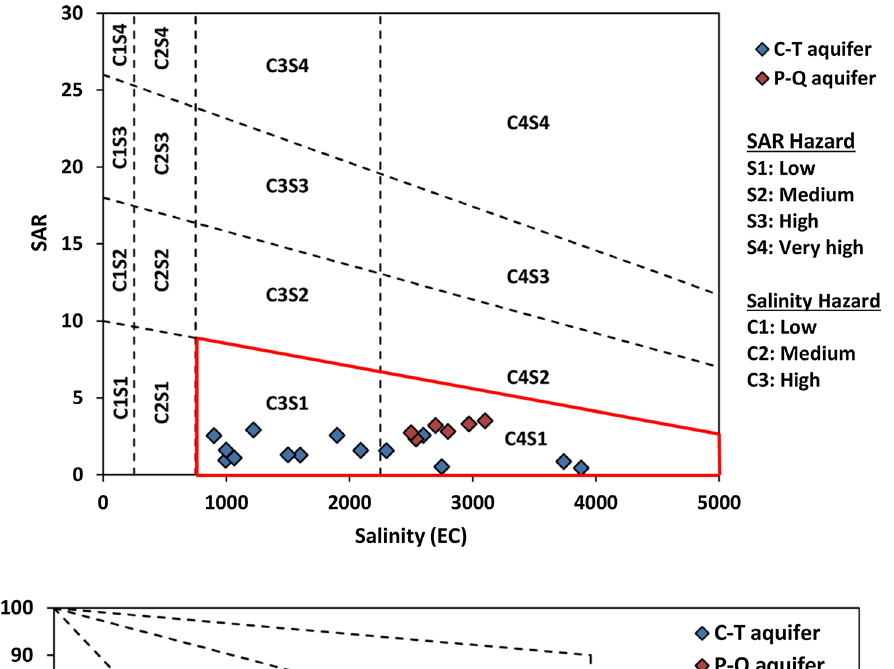
Fig. 9 Suitability of groundwa- ter for irrigation in Wilcox dia- gram. C-T = Cenomanian-Turo- nian, P-Q =